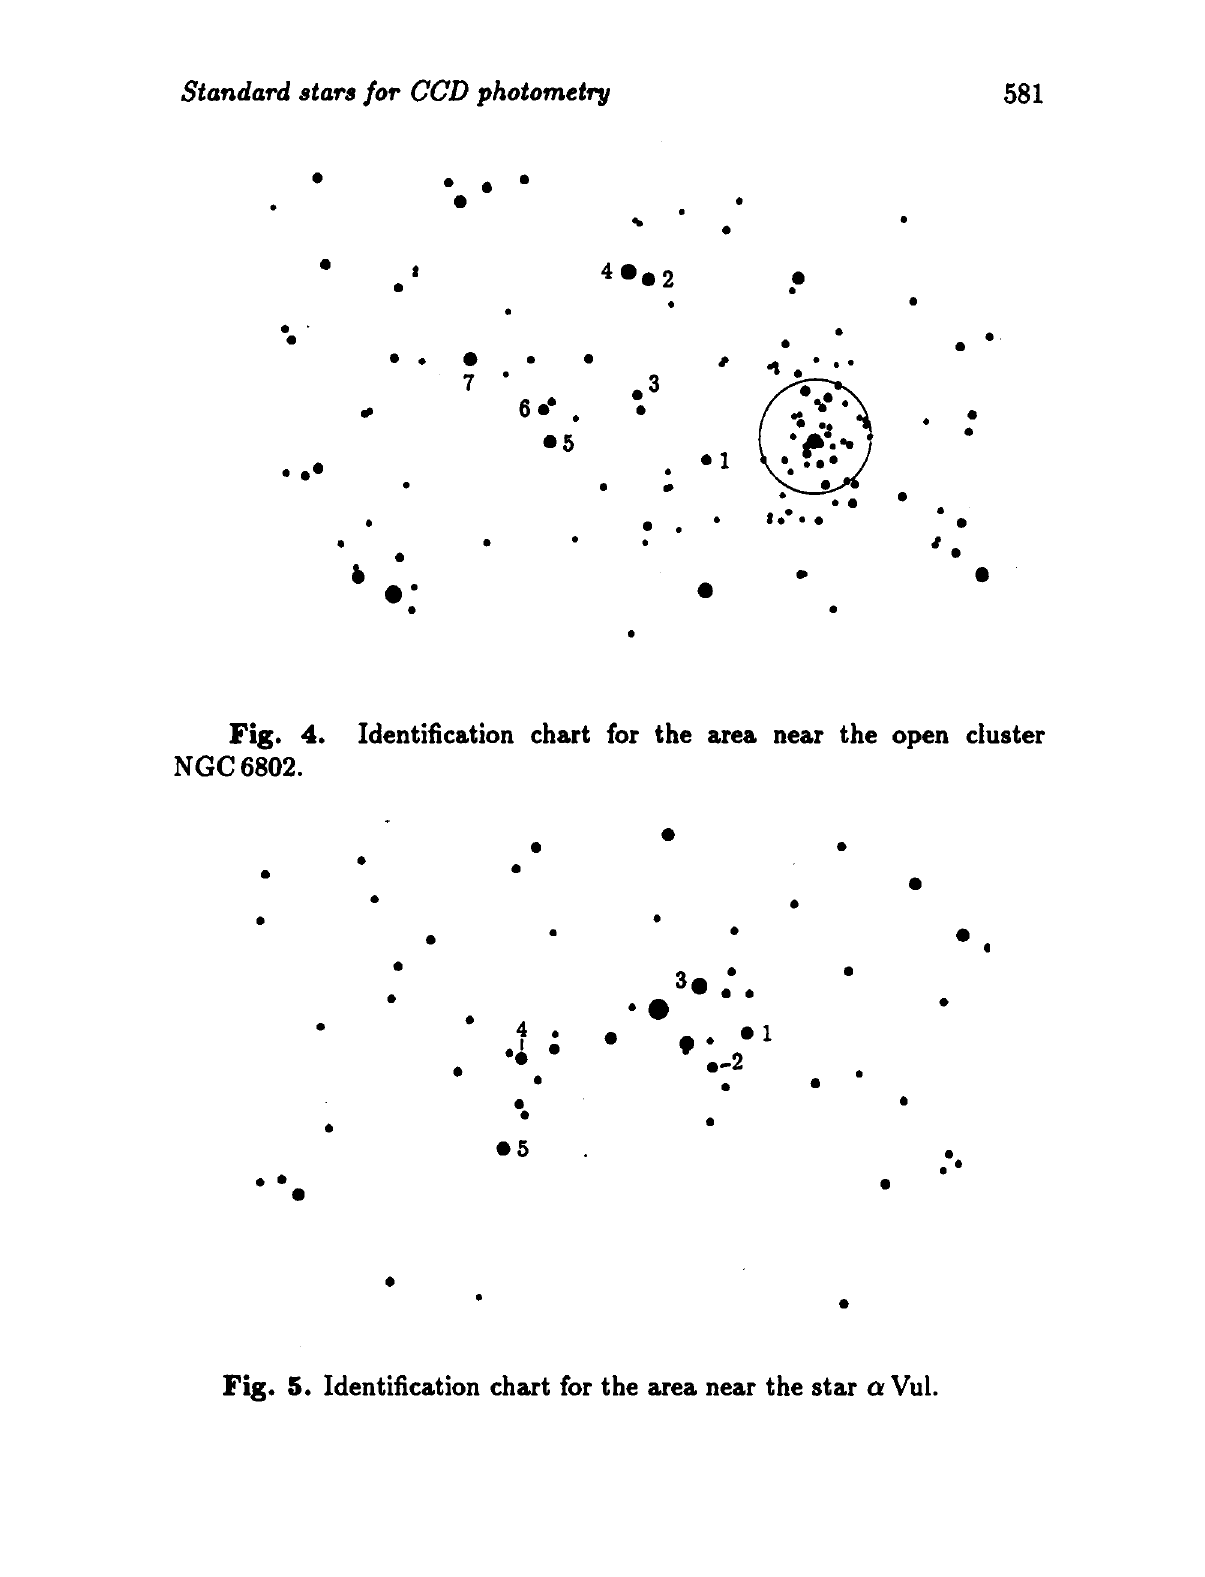
Fig. 5. Identification chart for the area near the star a